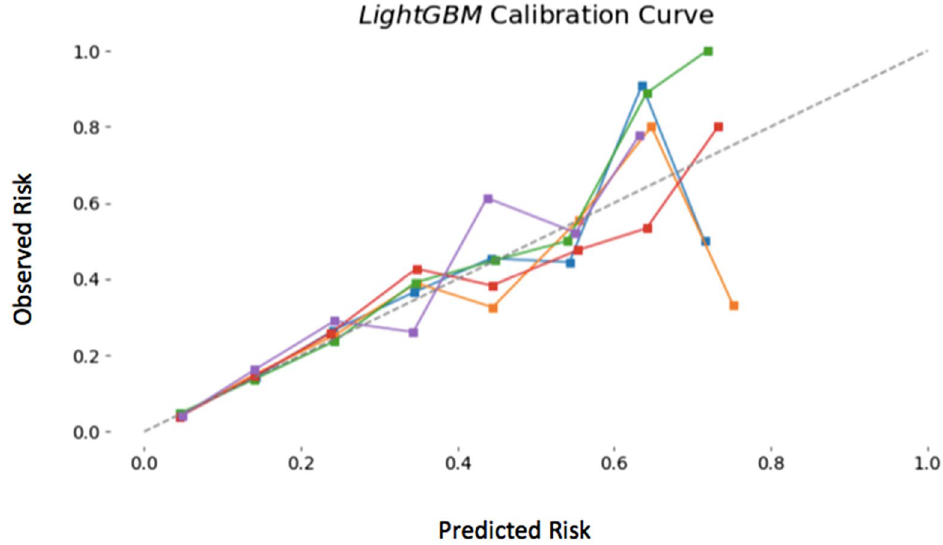
Figure 6. Calibration plot using the light GBM with age, eGFR, preprocedural hemoglobin, ST-elevation myocardial infarction, non-ST elevation myocardial infarction/unstable angina, heart failure symptoms at admission, and cardiogenic shock. Abbreviations: GBM: gradient boosting model; eGFR: estimated glomerular filtration